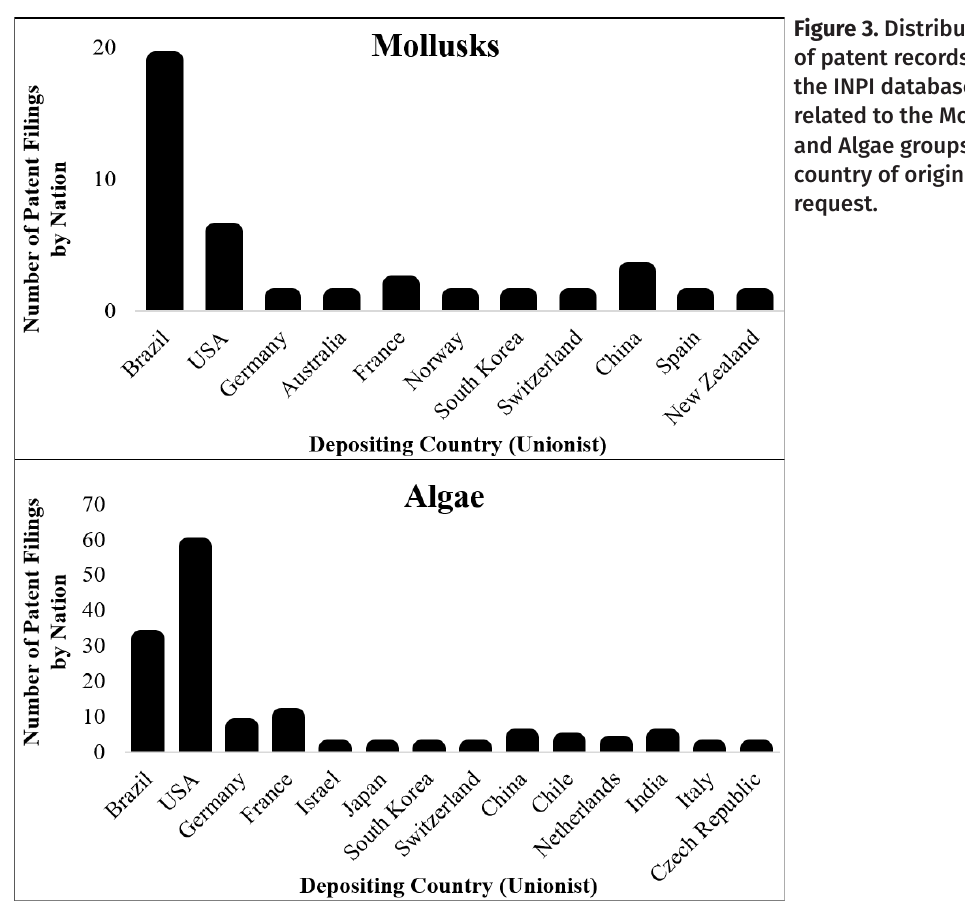
Figure 3. Distribution of patent records from the INPI database related to the Mollusk and Algae groups by country of origin of the